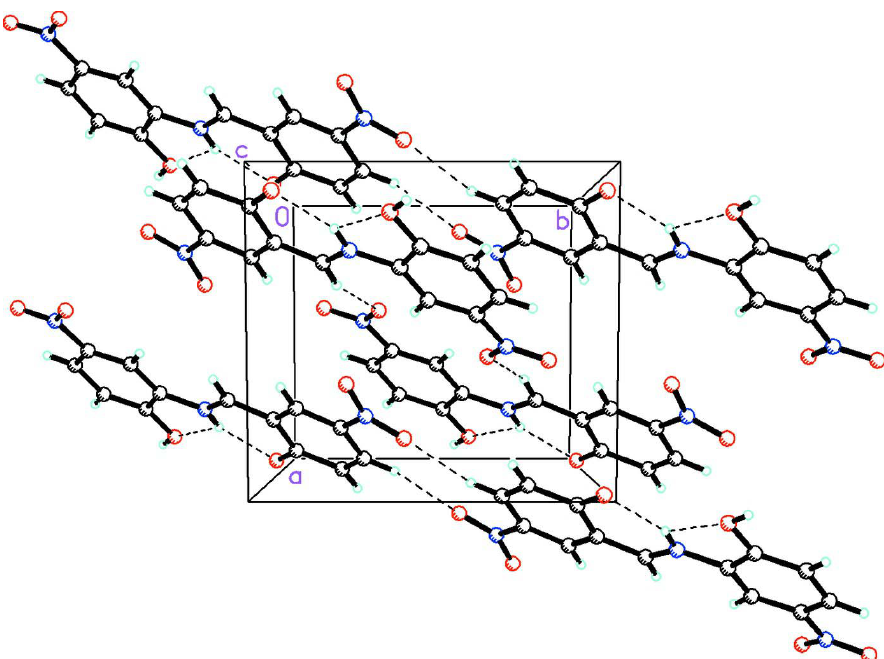
H N O viewed down the c axis. Dashed lines indicate intermolecular O–H···O, C–H···O 13 9 3 6